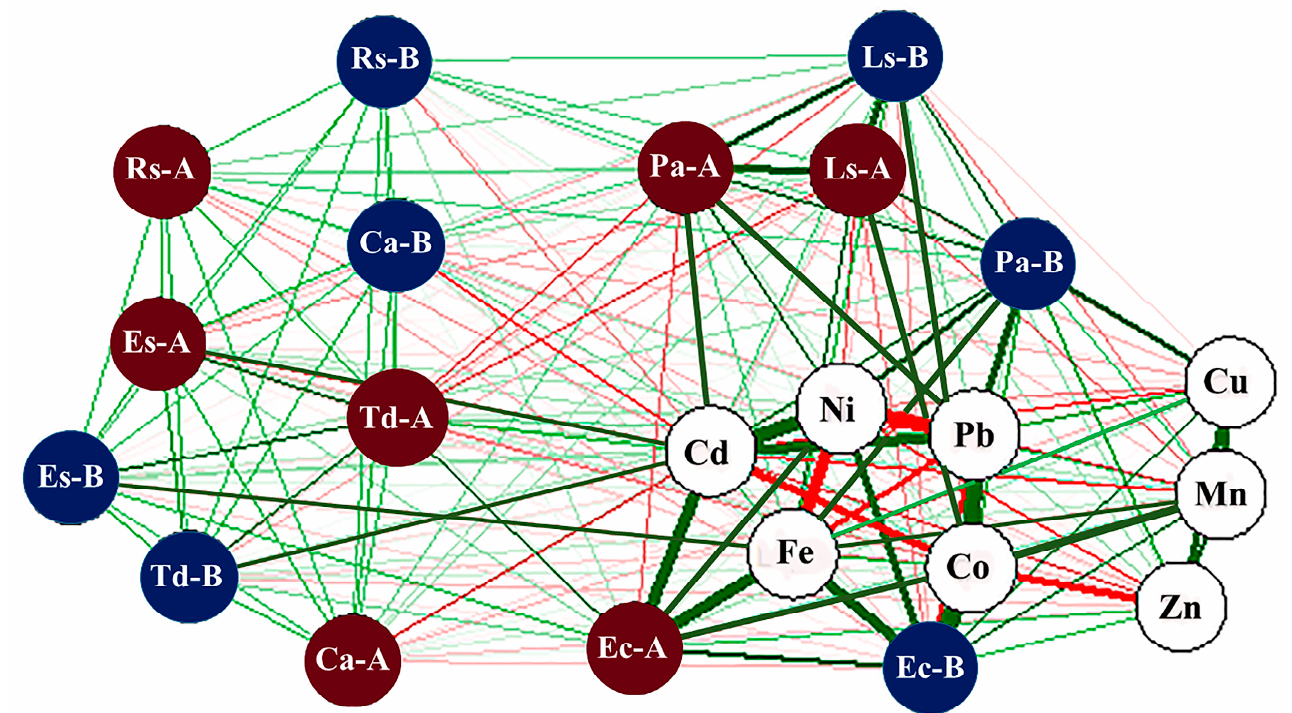
Figure 3. Pearson correlation network of heavy metals (Fe, Cu, Zn, Mn, Cd, Co, Ni, and Pb) in the aboveground (dark red circles) and belowground (blue circles) tissues of seven plant tissues. Positive correlations are indicated in green gradient